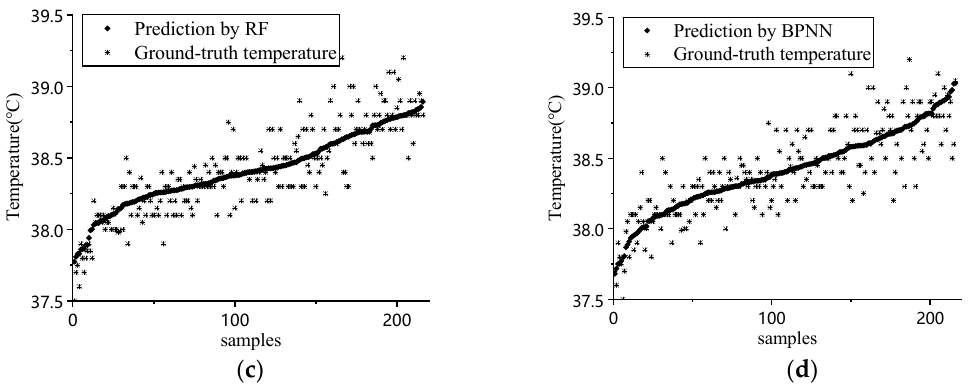
Figure 4. ( a ) Iteration process of GA; ( b ) prediction result comparison of GA-SVR; ( c ) prediction result comparison of RF; ( d ) prediction result comparison of BPNN.